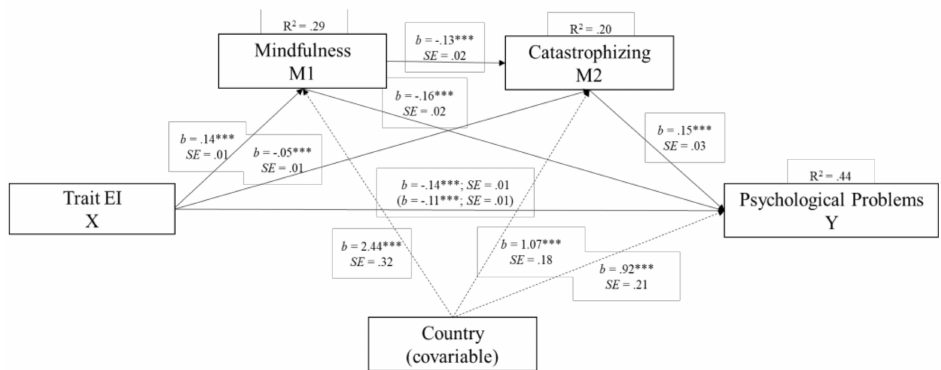
Figure 2. Double mediation model of the relationships among trait emotional intelligence, mindfulness skills, catastrophizing thoughts, and psychological problems, after controlling for country of origin (Portugal vs. Spain). Statistical diagram of the double mediation model for the expected influence of EI and its association through mindfulness and catastrophizing on psychological problems, and the country as a covariate. The values are represented with unstandardized regression coe ffi cients. In the association between Trait EI and psychological problems, the value outside brackets represents the total e ff ect, and the value in brackets represents the direct e ff ect of the bootstrapping analysis of Trait EI on Psychological Problems after the inclusion of the mediating variables. *** p <